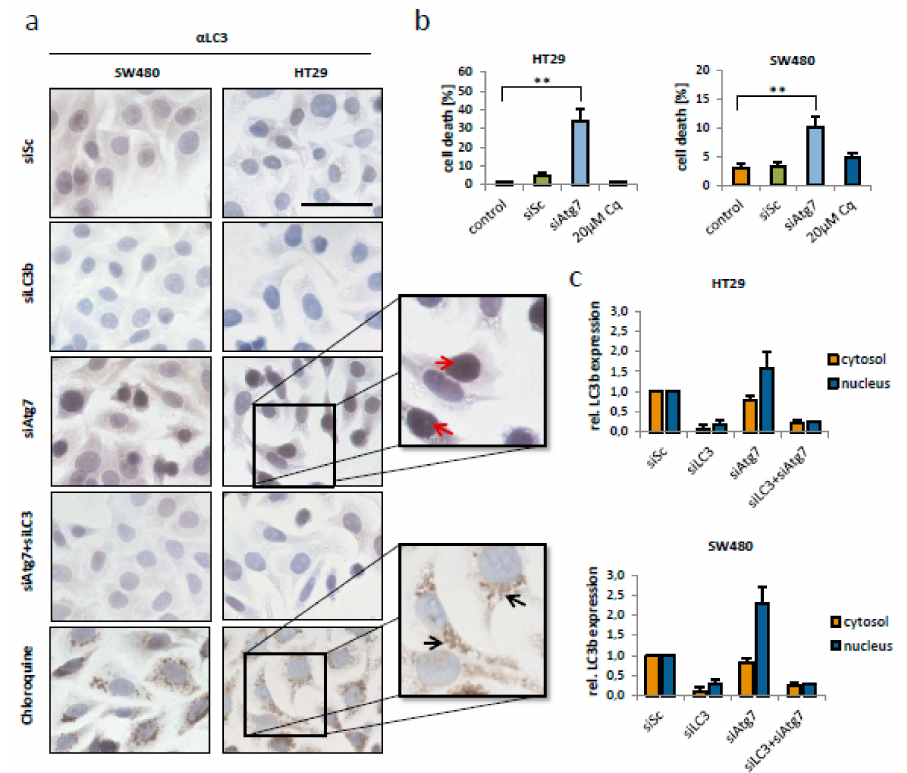
Figure 4. LC3b translocated into the nucleus of colorectal cancer cells after knockdown of Atg7. ( a ) Immunohistochemical staining for LC3b in HT29 and SW480 cells after siRNA-mediated knockdown of Atg7 and / or LC3b (80 nM) and treatment with chloroquine (20 µ M) for 48 h. Red arrows indicate nuclear LC3b in siAtg7 transfected cells, black arrows indicate LC3b foci in the cytosol of chloroquine treated CRC cells (scale bar indicates 50 µ m). ( b ) Flow cytometry for apoptosis induction after transfection with siRNA targeting Atg7 (80 nM) and treatment with chloroquine (Cq) for 48 h in HT29 (left) and SW480 (right) cells. ( c ) Densitometric analyses of Western blots, quantifying LC3b levels in the cytosol and nucleus of HT29 and SW480 cells, 48 h post transfection with siAtg7 and / or siLC3b (80 nM). Data represent mean + SD of independent biological